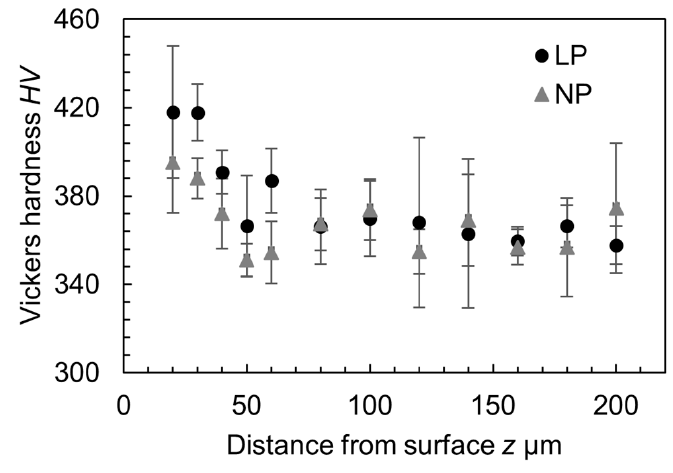
Figure 13. Hardness of cross-sectional area.